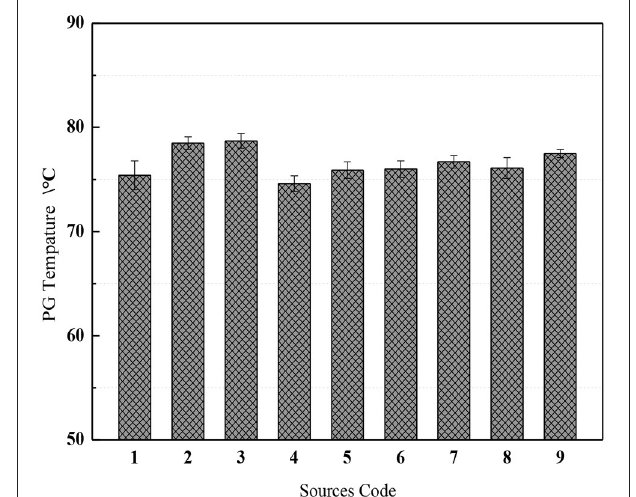
FIGURE 4 | High temperature grading of TPU-modified